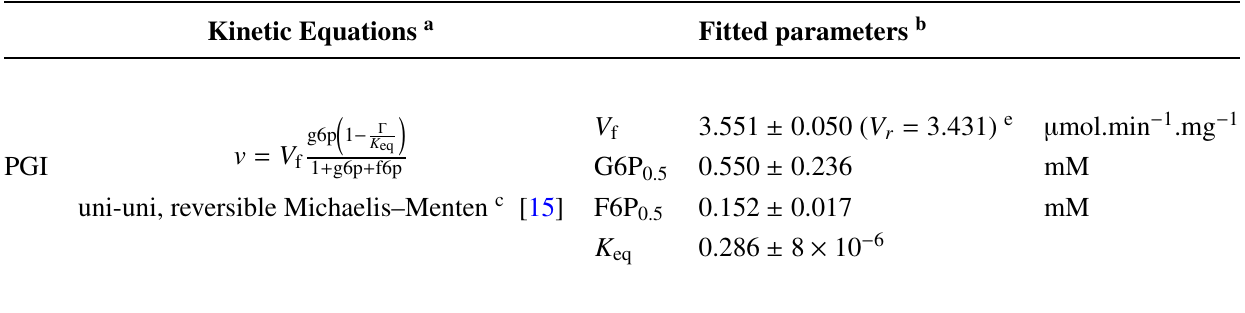
Table 1. Kinetic Equations and Fitted Parameters for the PGI and PFK